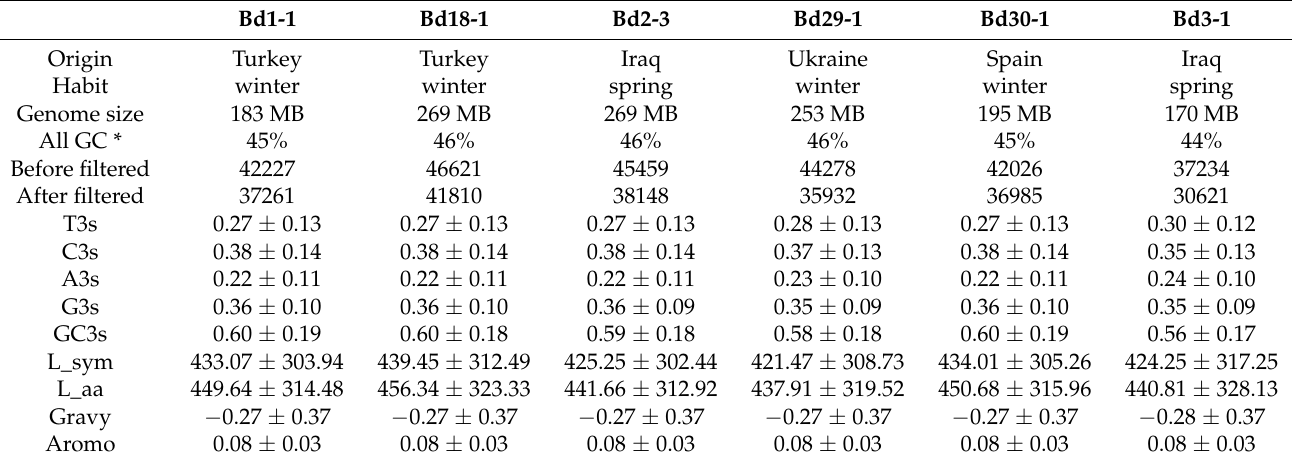
Table 1. For the nucleotide composition, there were tiny differences at the third positions of the codons among the six inbred lines, conforming to C > G > T > A, which suggested that a similar codon composition was present in B. distachyon . The GC3s’ values were greater than 0.55, indicating that the six lines tended to use codons with G and C at the third codon positions. In Bd3-1, the G3s, C3s and GC3s were less than in the other five lines (Figure 1a). Table 1. The information pertaining to the six B. distachyon lines.